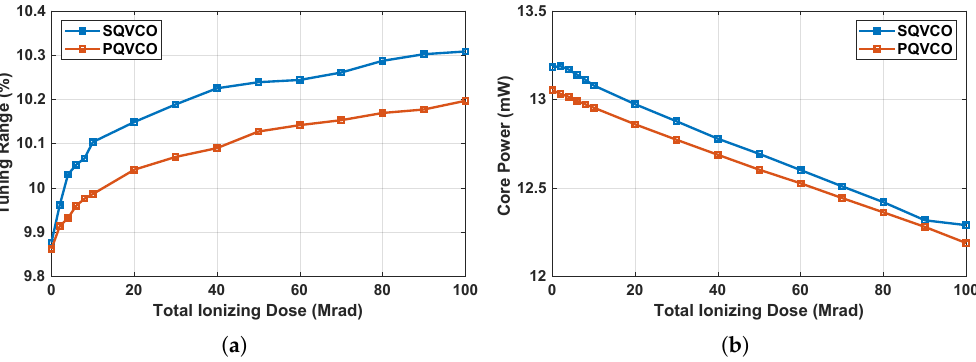
Figure 9. ( a ) Tuning ranges, ( b ) core power consumption of SQVCO and PQVCO measured with respect to the TID of the order of 100 Mrad (SiO 2